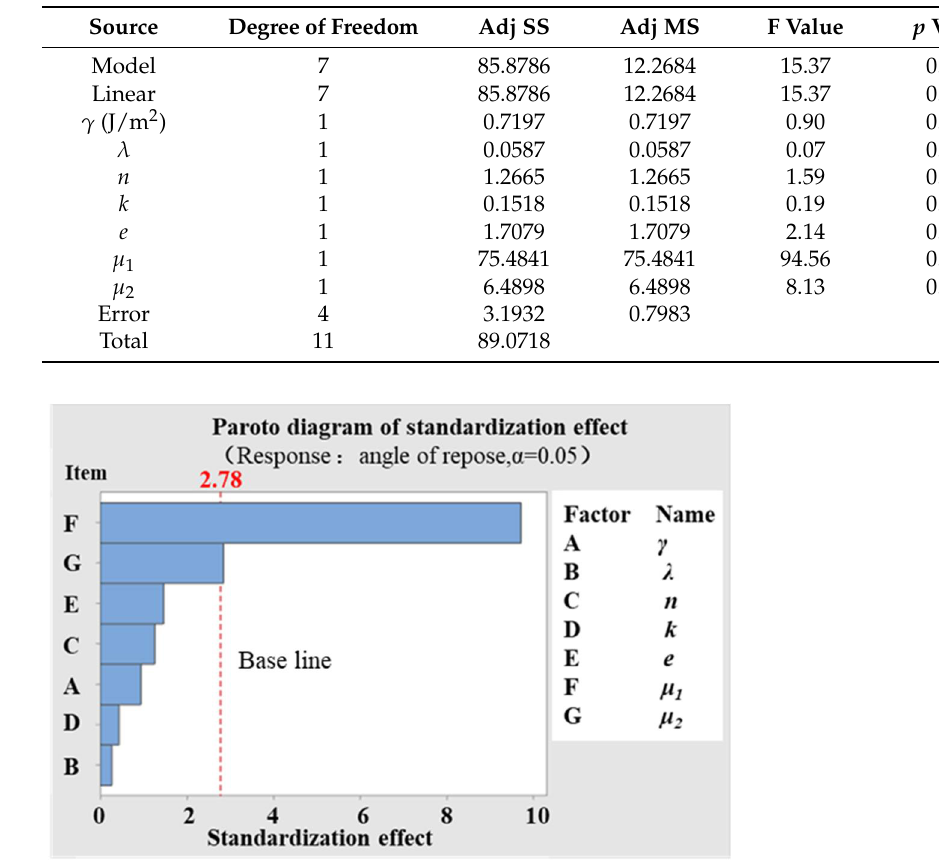
Table 3. Analysis of variance.